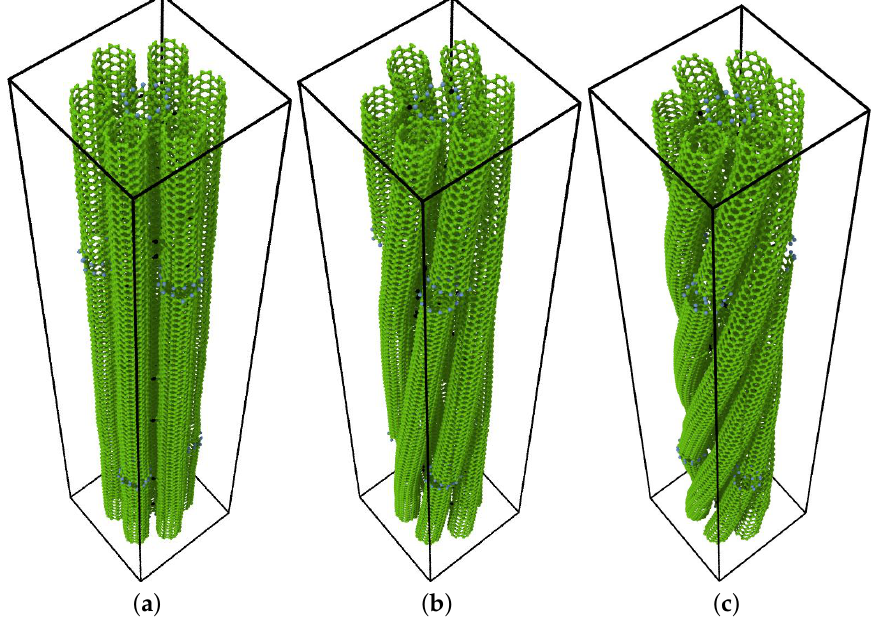
Figure 2. Structural models used for the simulations of the straight ( a ) and twisted ( b , c ) ( 6,6 ) CNT bundles with linkers connecting the nanotubes. The linkers are reported in black and are made of carbon atoms bonded to the nanotubes. Hydrogen atoms (in blue) saturate dangling